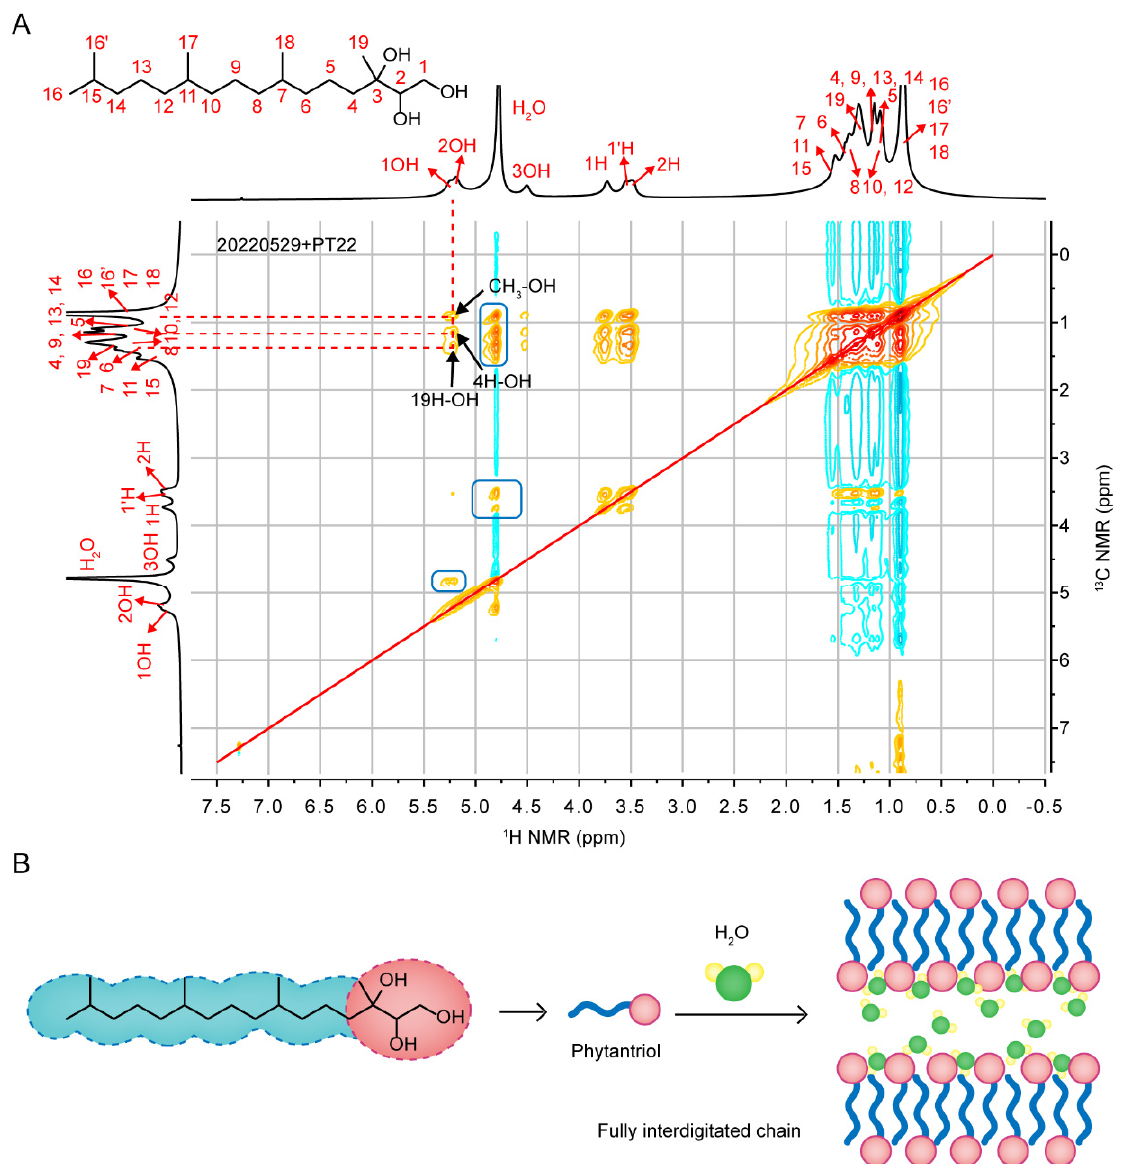
Figure 6. ( A ) The two-dimensional 1 H- 1 H NOESY spectrum of PT22 on day 63. ( B ) The bulk structure and isotropic phase model of a phytantriol/water system.